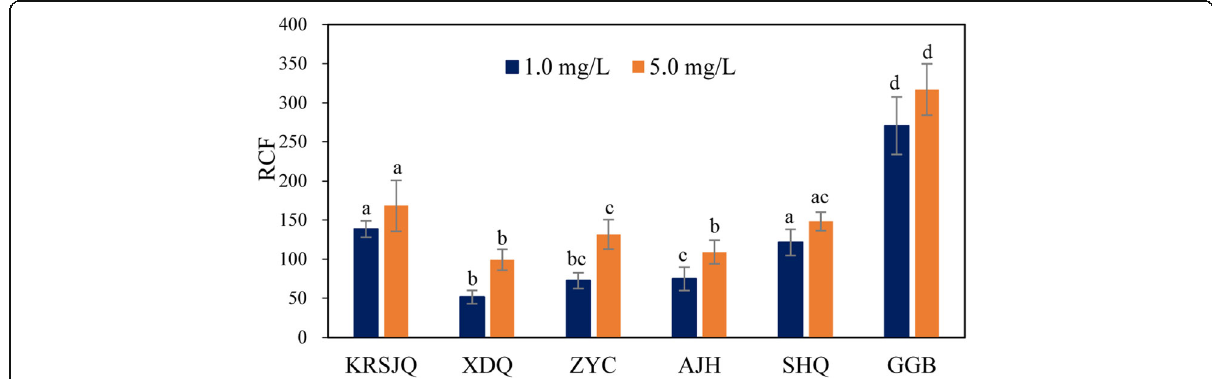
Fig. 1 The root concentration factor (RCF) for six vegetables (Kangresijiqing (KRSJQ), Xiadiqing (XDQ), Ziyoucai (ZYC), Aijiaohuang (AJH), Shanghaiqing (SHQ) and Gaogengbai (GGB)) in 1.0 mg/L and 5.0 mg/L treatments. Each treatment consisted of five replicates. The bars with the different letter(s) were significantly different ( p < 0.05)